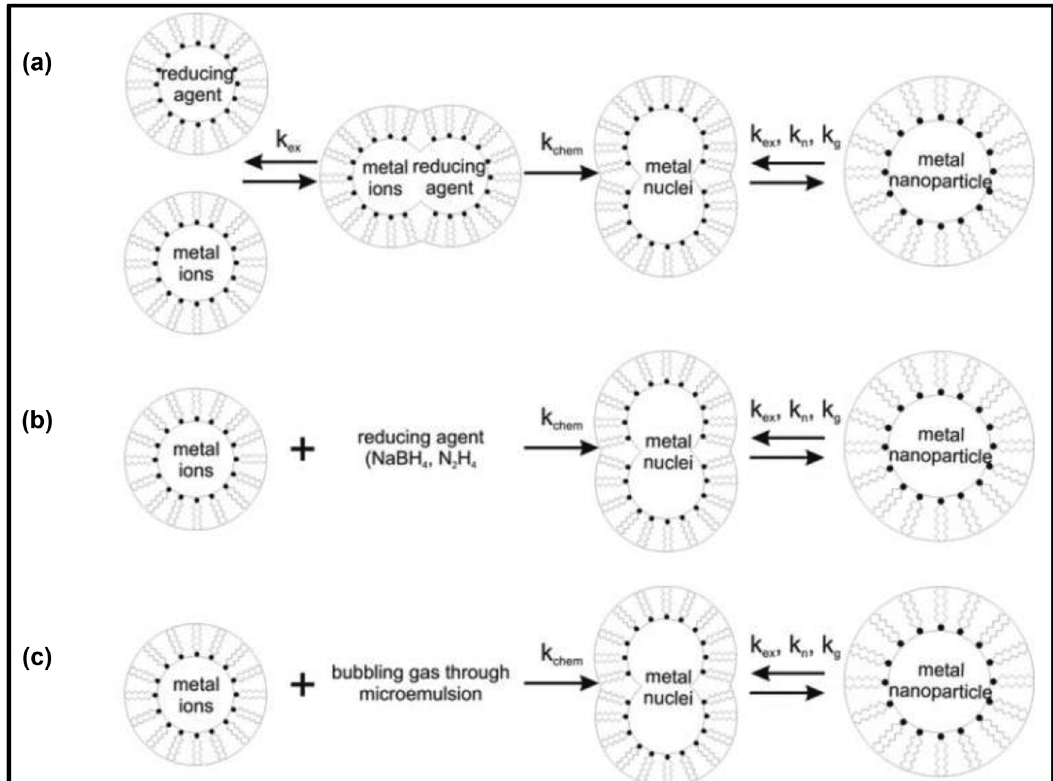
Figure 2: A schematic presentation of preparation of nanoparticles by microemulsion methods [ 50 ]